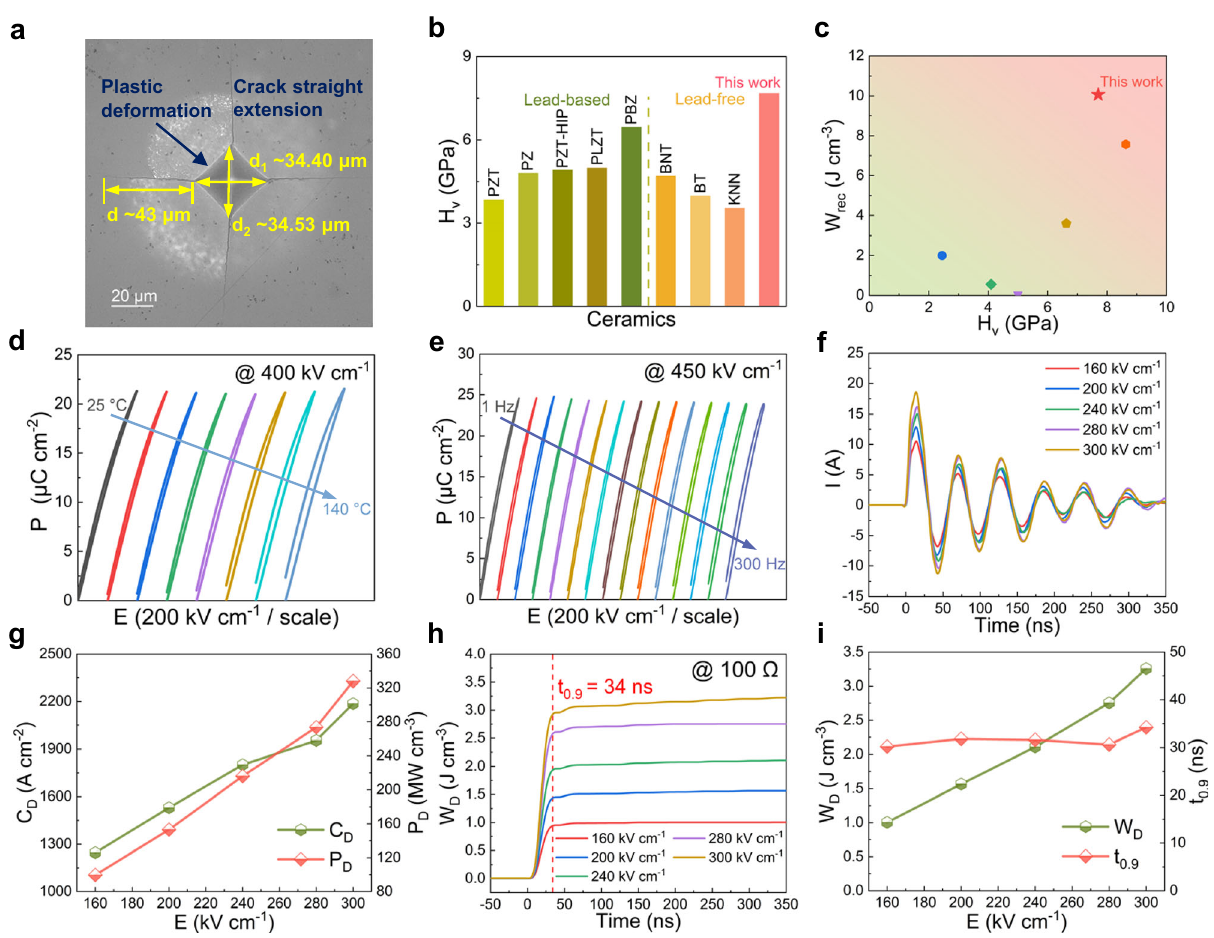
Fig. 5 The hardness, stability and charge/discharge performance of KNN-H ceramic. a The surface patterns produced by the Vickers diamond indenter. b A comparison of H v between KNN-H ceramic and some representative lead-free ceramics. c A Comparison of W rec versus H v between KNN-H ceramic and other reported lead-free ceramics. d Temperature-dependent P - E loops at 400 kV cm − 1 . e Frequency-dependent P - E loops at 450 kV cm − 1 . f Underdamped discharge waveforms, and g C D , and P D values under different electric fi elds. h W D as a function of time, and i W D , and t 0.9 values under different electric fi elds ( R = 100 Ω